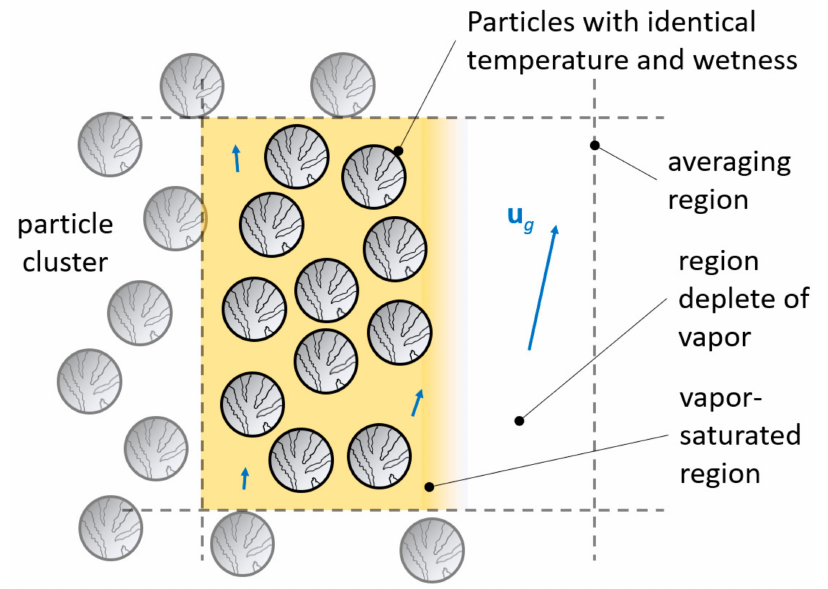
Figure 11. Illustration of the effect of clustering on drying rates (the yellow-colored region indi- cates